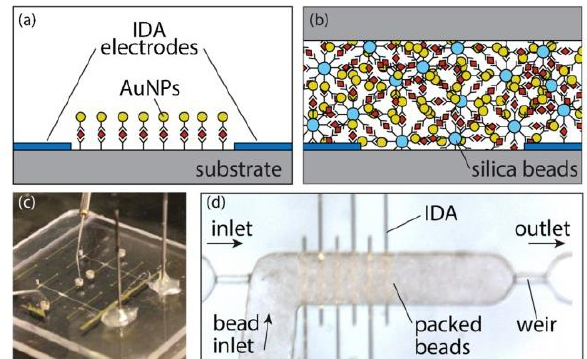
Figure 10. Idealized views of: ( a ) planar; ( b ) a volumetric impedimetric immunosensor; ( c ) fabricated thermoplastic device; and ( d ) magnified view of the detection zone, including thin-film gold IDEA and packed bed of functionalized silica beads in a 150 µ m deep channel. Reprinted from [180], Copyright 2016, with permission from Elsevier. Table 3. IDEA based-electrochemical sensor in biomedical applications using amperometric and impedimetric